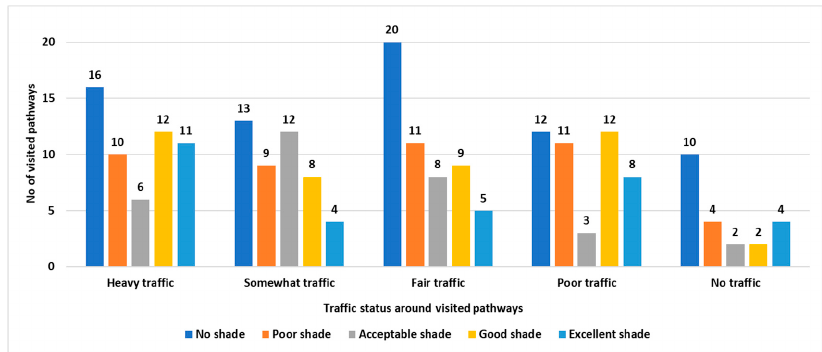
Figure 5. Cross-tabulation shows the relationship between shadiness and traffic of visited pathways.